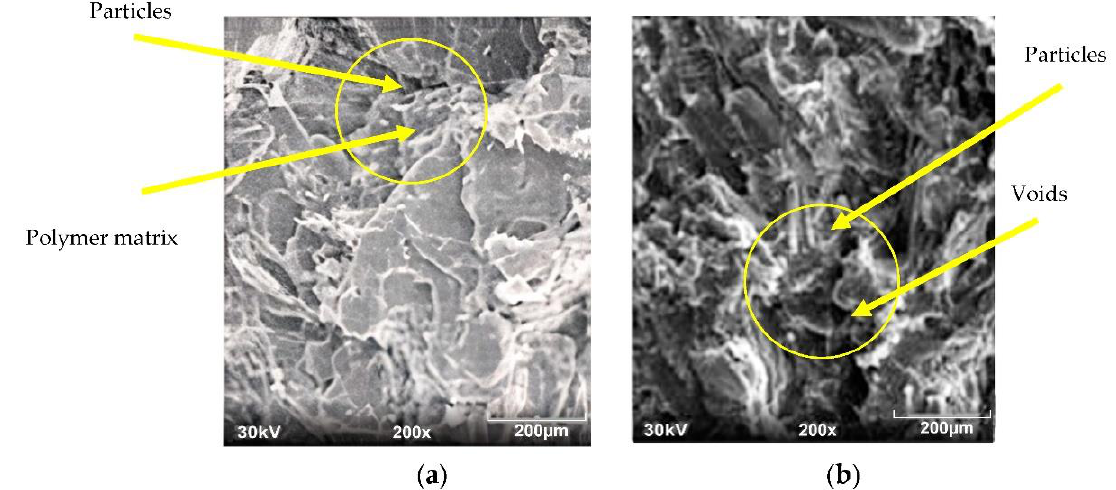
Figure 8. SEM images of the tensile fracture surfaces of the CCWW particles-epoxy-composites specimens (200 × ): ( a ) CP3 and ( b ) CP4.